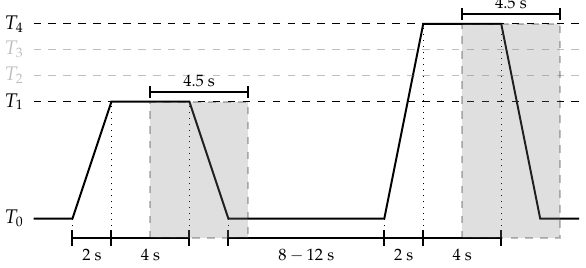
Figure 5. Video Signal Segmentation (BioVid Heat Pain Database (Part A)). Experiments are carried out on windows of length 4.5 s with a temporal shift of 4 s from the elicitations’